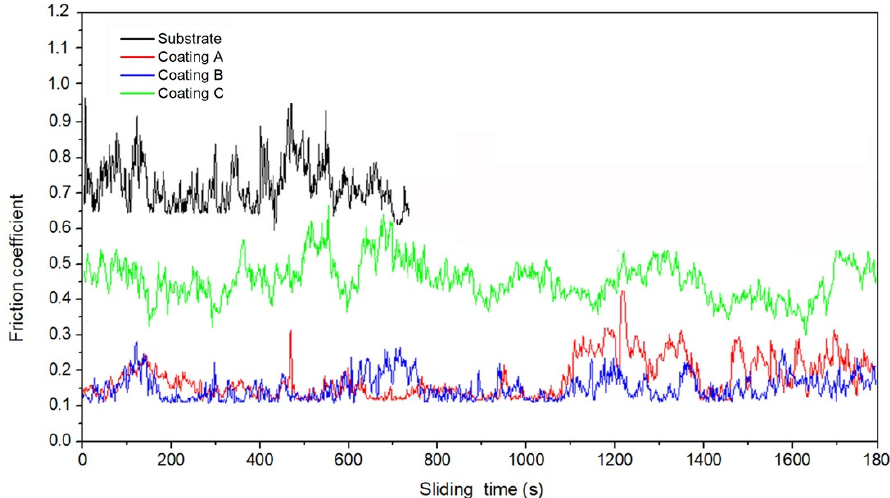
Figure 5. Friction coefficient of substrate and three coatings versus the sliding time.